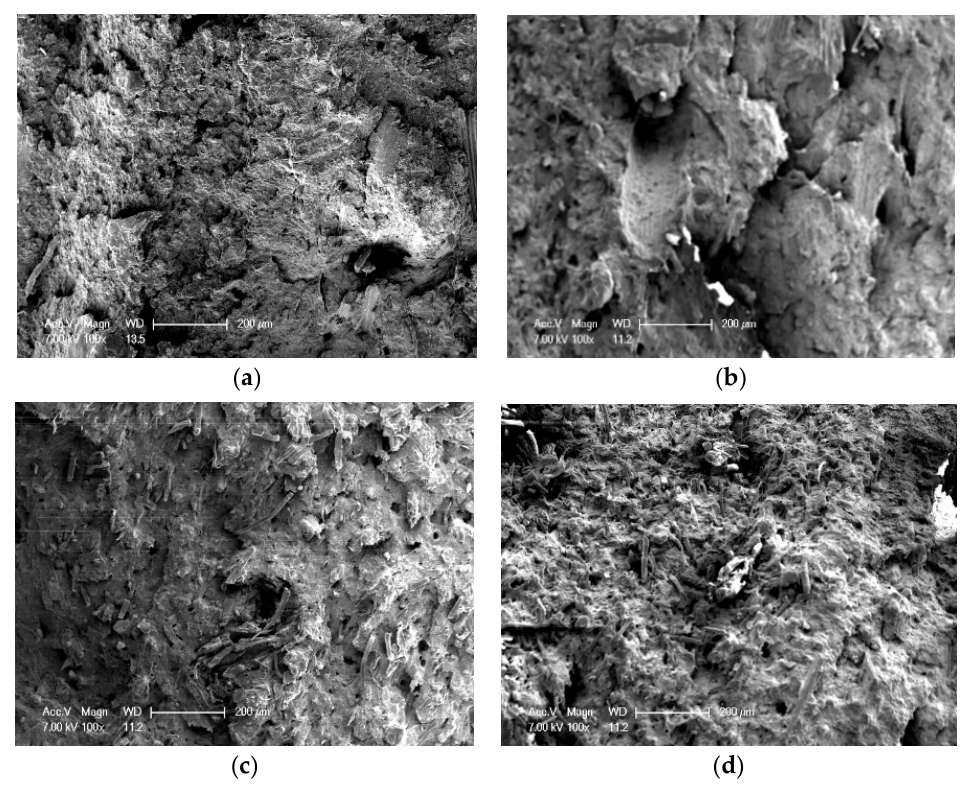
Figure 4 . Microstructure of fracture surfaces of BPCs specimen: ( a ) containing 0% of BPF; ( b ) containing 20% of BPF; ( c ) containing 30% of BPF; ( d ) containing 40% of BPF.